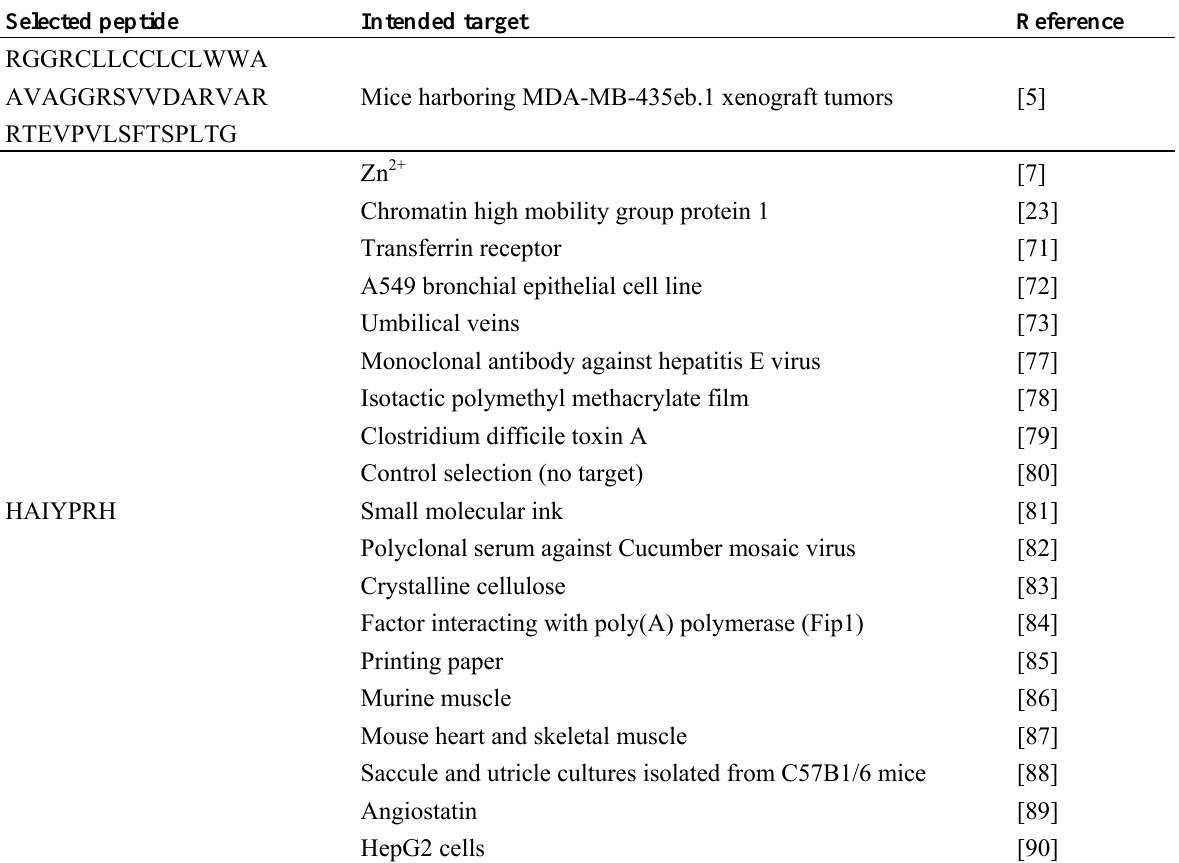
Table 2. Propagation-related target-unrelated